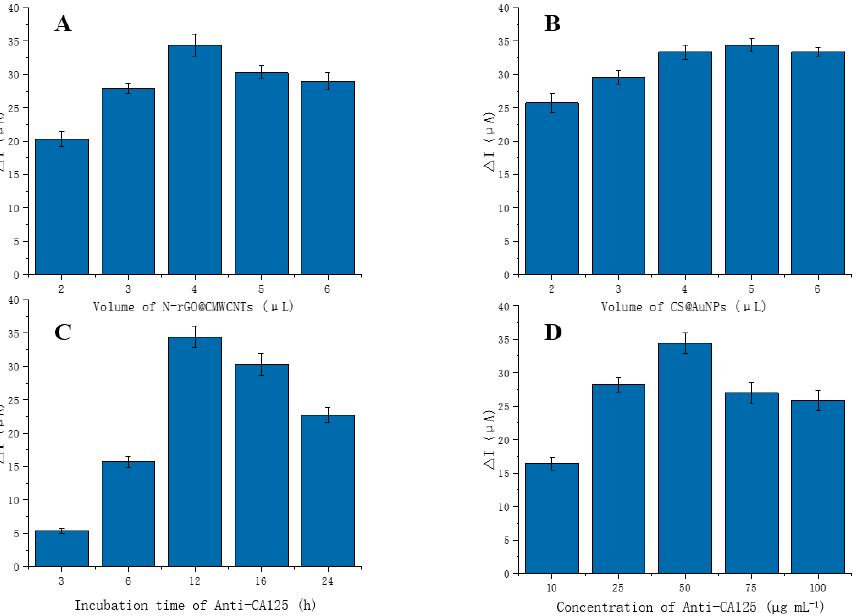
Figure 5. Optimization of experimental conditions ( A ) volume of N-rGO@CMWCNTs; ( B ) volume of CS@AuNPs; ( C ) incubation time of Anti-CA125; and ( D ) concentration of Anti-CA125.